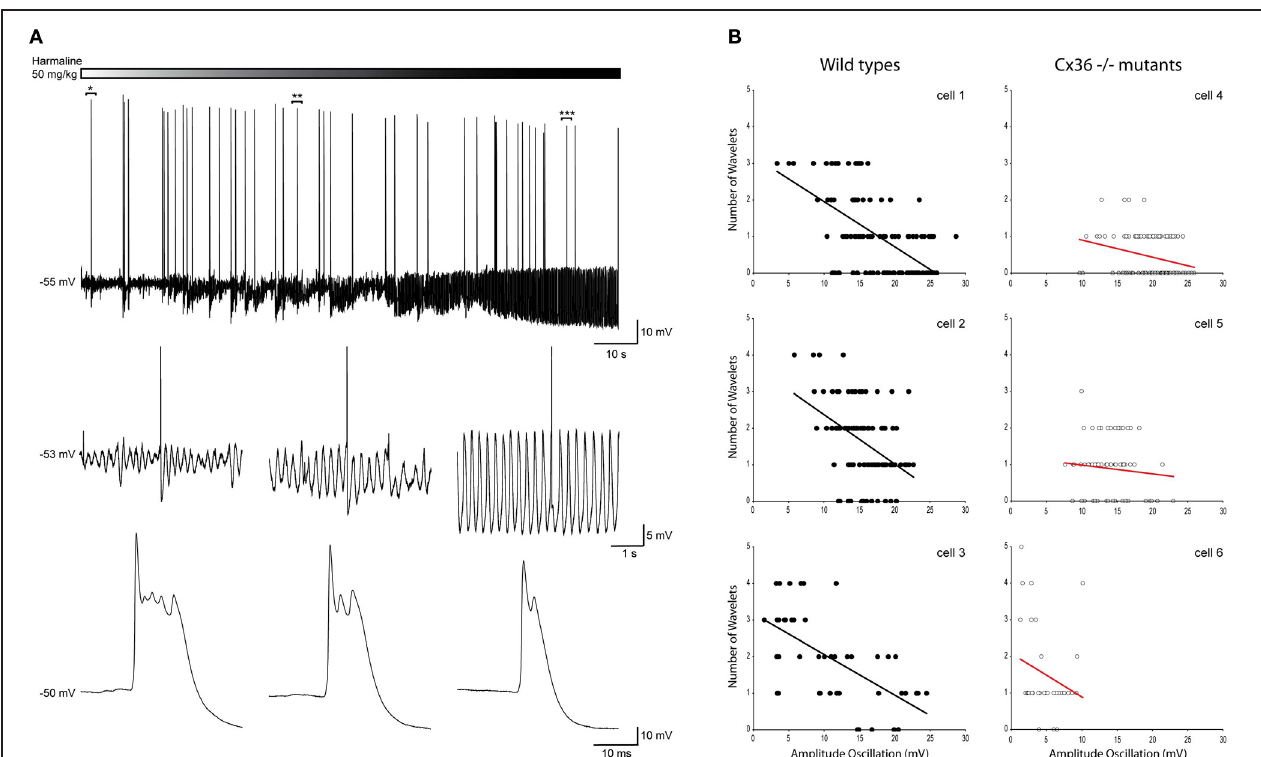
FIGURE 7 | Harmaline induced alteration of the oscillation amplitude confirms the negative relationship between the amplitude of the SSTOs and the number of wavelets on the ADP of olivary spikes within a single cell. (A) Top panel: trace of a spontaneous sinusoidal subthreshold oscillating olivary neuron ( in vivo ) during the application of harmaline. Middle panel: three magnifications obtained from the trace above. Magnifications were taken from the marked time windows (*, **, and ***) and show the effect of harmaline on the subhreshold oscillation. Lower panel: enlargement of the olivary action potential shown in the panel above. The number of the olivary wavelets on top of the